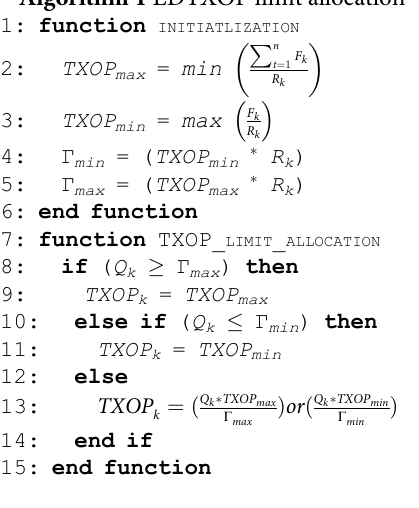
Algorithm 1 EDTXOP limit allocation